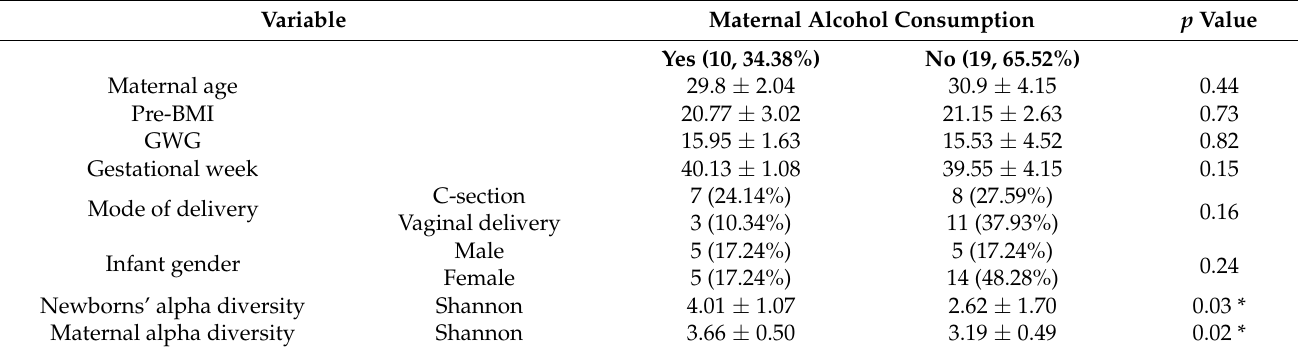
Table 1. Characteristics of maternal and infant birth cohort (N =